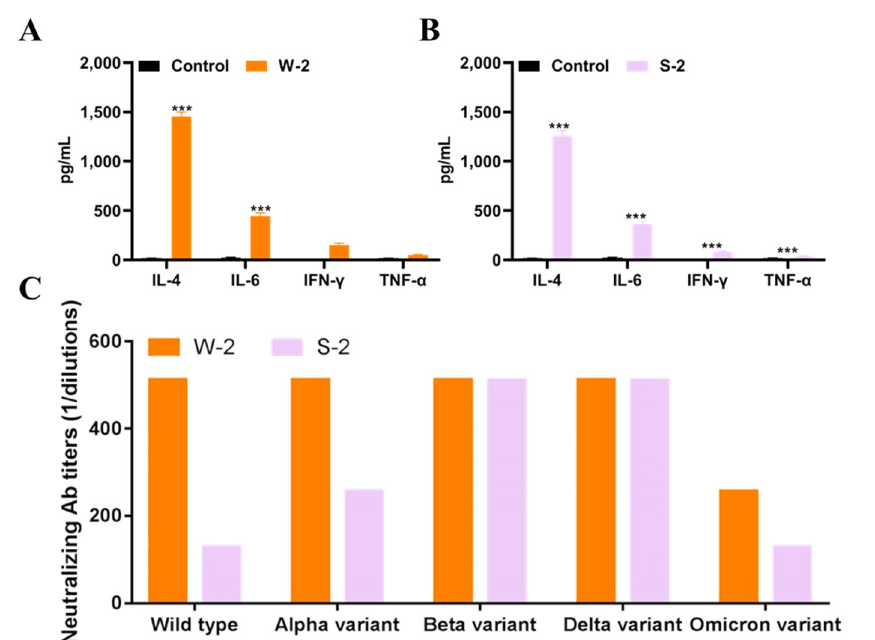
Figure 6. Cytokine and neutralizing antibody levels in immunized mice. IL-4, IL-6, TNF- α and IFN- γ levels in W2 ( A ) and S2 ( B ) mice were detected by ELISA. ( C ) Neutralization activities of W2 and S2 mice against wild-type, Alpha, Beta, Delta and Omicron variants were assayed by live virus. Data are presented as mean ± SD; ***, p < 0.001. All experiments were repeated at least twice.